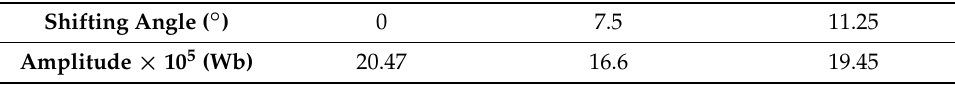
Table 2. Amplitude of magnetic flux in a single stator coil.